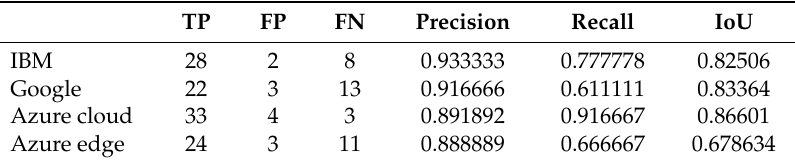
Table 1. Accuracy measurement in di ff erent